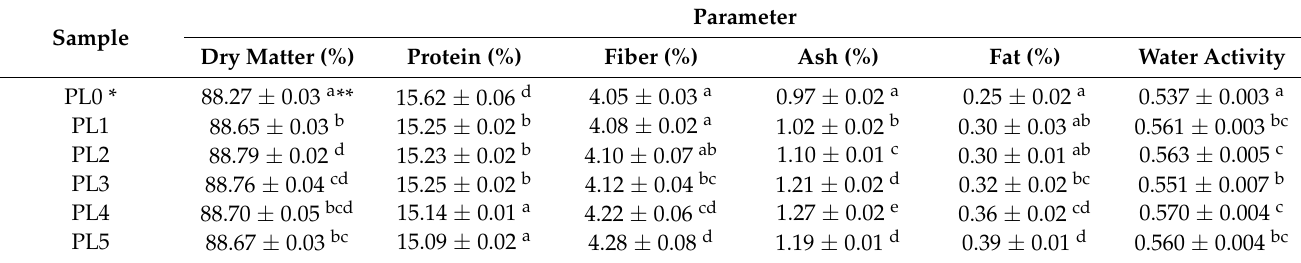
Table 1. Chemical composition (%) and water activity of the pasta enriched with green